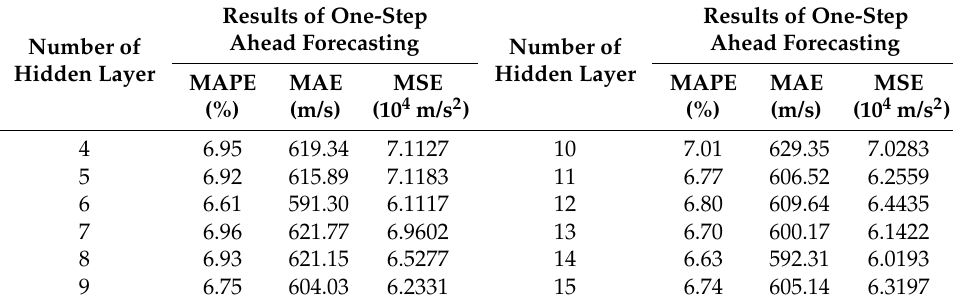
Table 2. Parameters and performance results of the developed neural networks for all the simulations. Results of One-Step Results of One-Step Ahead Forecasting Ahead Forecasting Number of Number of Hidden Layer Hidden Layer MAPE MAE MSE (%) (m/s) (10 4 m/s 2 )